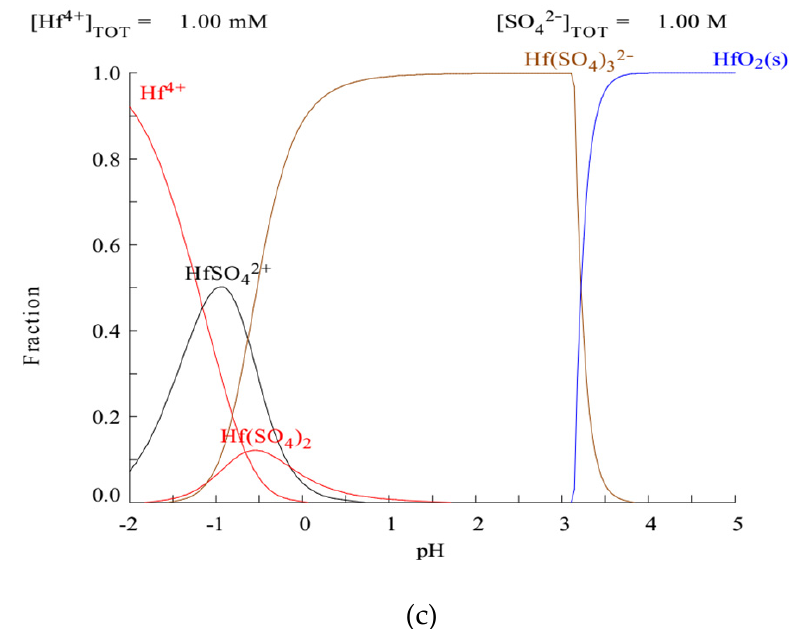
Figure 2. Predicted fraction diagrams of ( a ) Nb, ( b ) Zr, and ( c ) Hf in aqueous solutions using